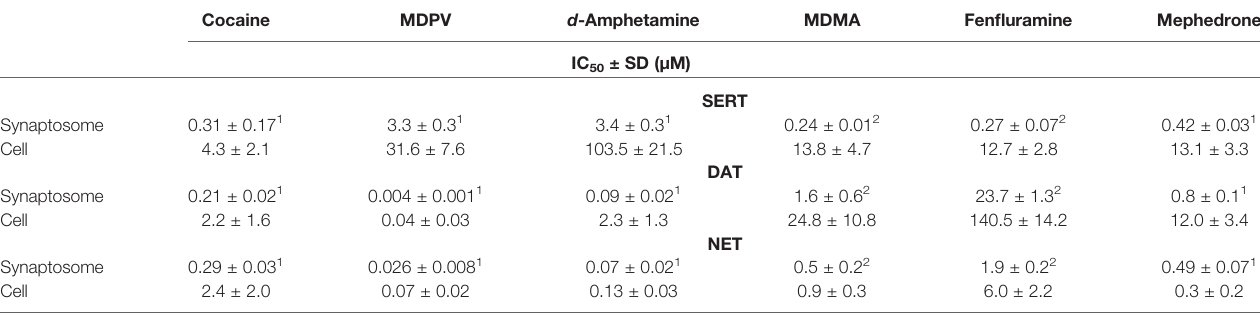
TABLE 5 | Radioligand uptake inhibition in rat synaptosomes and HEK 293 cell lines stably expressing rat